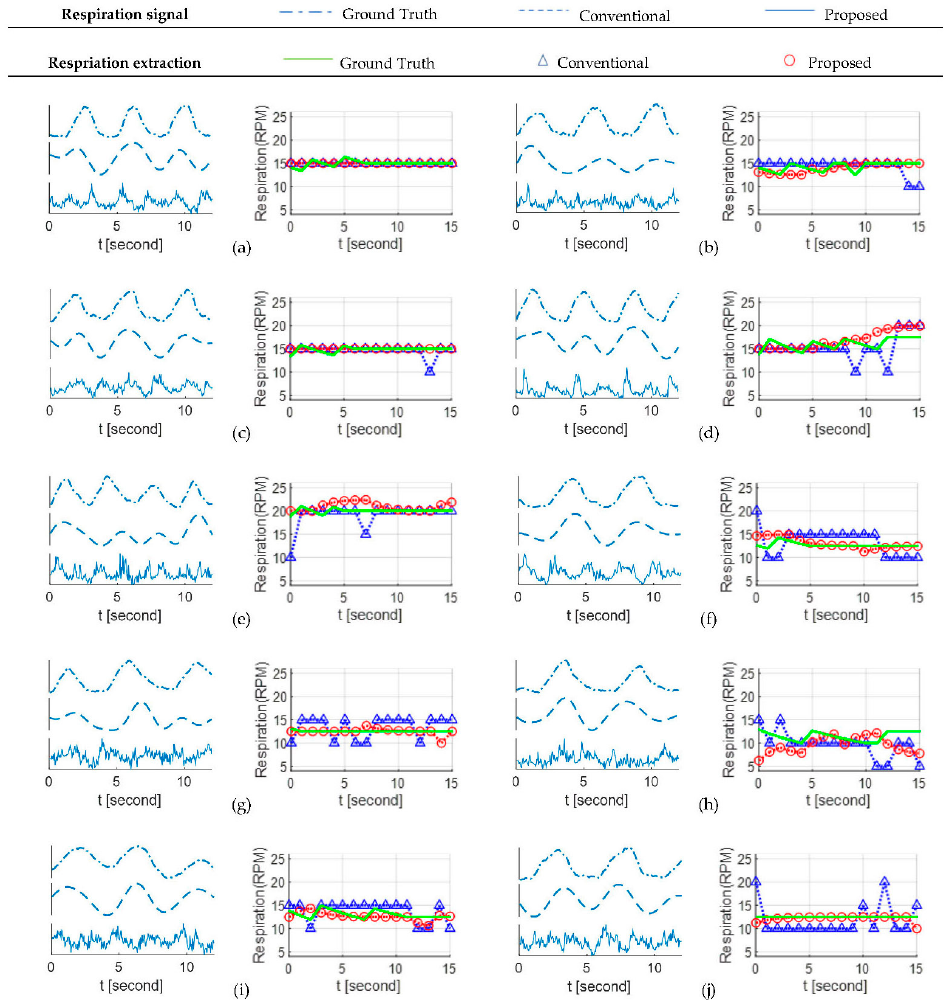
Figure 8. Respiration extraction results for the case shown in Figure 5a. ( a ) Subject #1, ( b ) Subject #2, ( c ) Subject #3, ( d ) Subject #4, ( e ) Subject #5, ( f ) Subject #6, ( g ) Subject #7, ( h ) Subject #8, ( i ) Subject #9, and ( j ) Subject